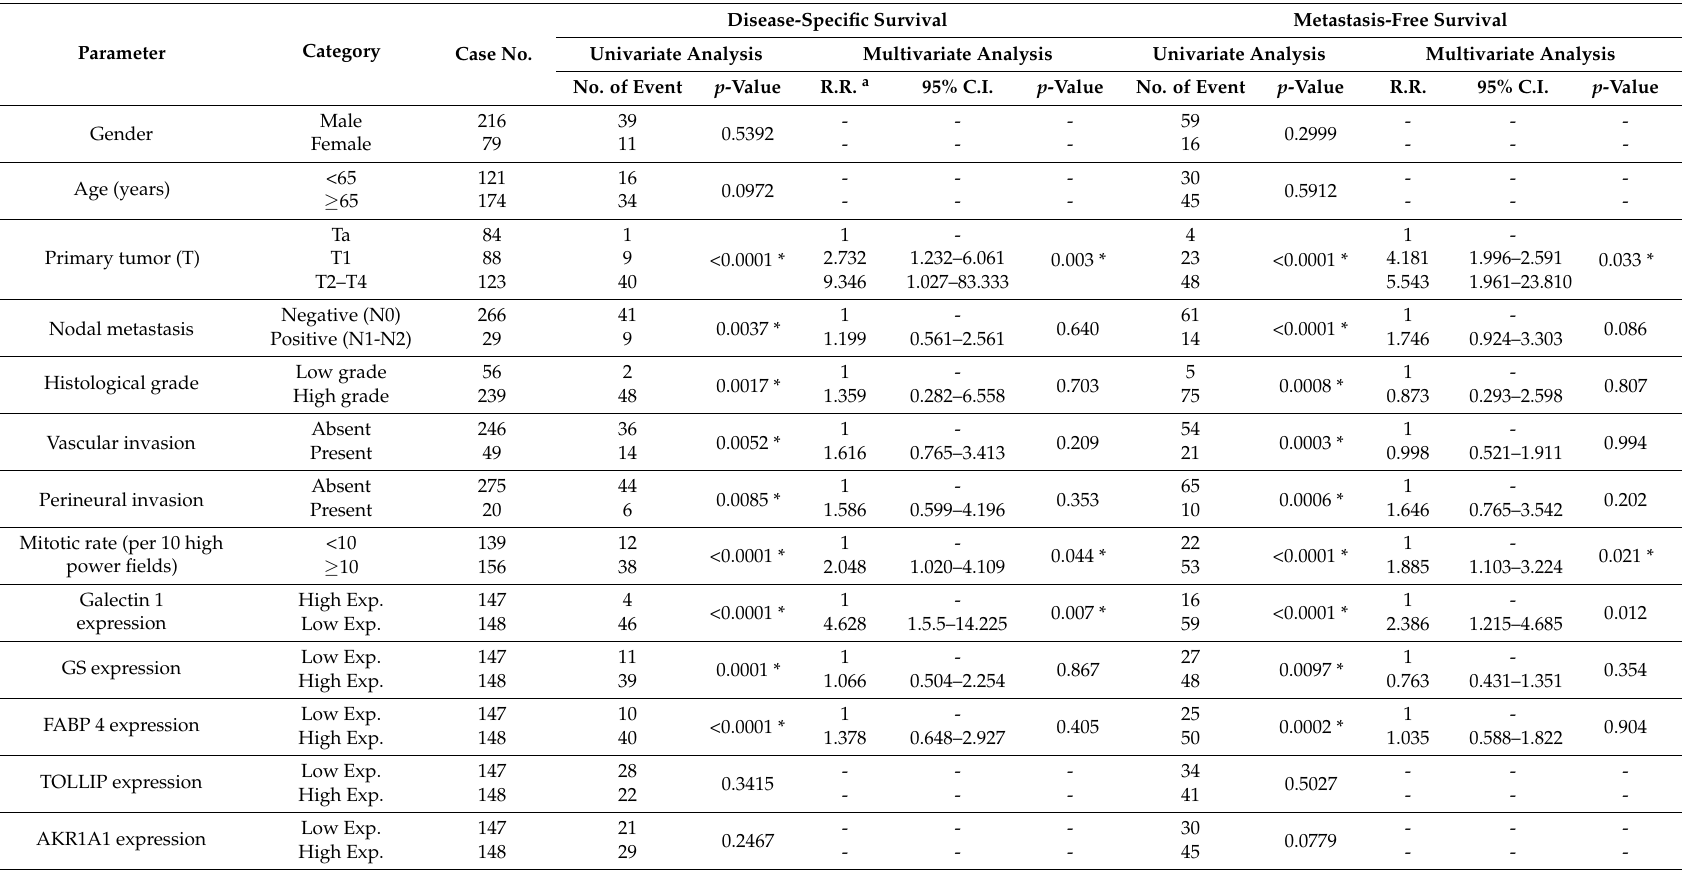
Table 3. Univariate log-rank and multivariate analyses for Disease-specific and Metastasis-free Survivals in urinary bladder urothelial carcinoma. Disease-Specific Survival Metastasis-Free Survival Parameter Category Case No. Univariate Analysis Multivariate Analysis Univariate Analysis Multivariate